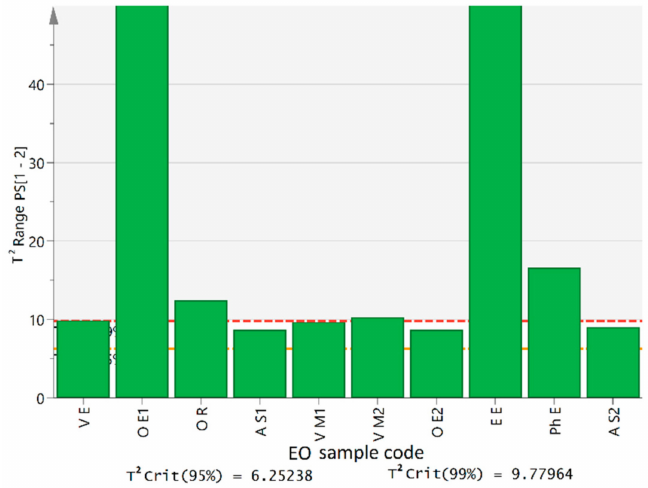
Figure 6. Hotelling’s T 2 plot displaying the predicted variance of all the commercial EOs from the one-class model of reference bay laurel EOs (S L1—V L2); eucalyptus EOs (V E—Ph E), rosemary (O